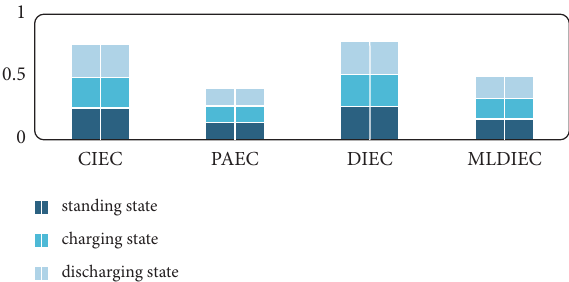
Figure 16: Comparisons of energy loss of the four equalization circuits.